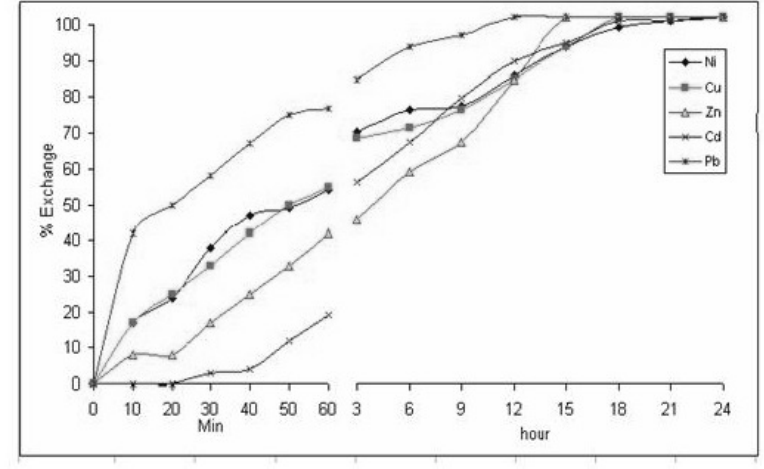
Figure 3 . Rate of exchange for metal ions exchange capacity on AFM